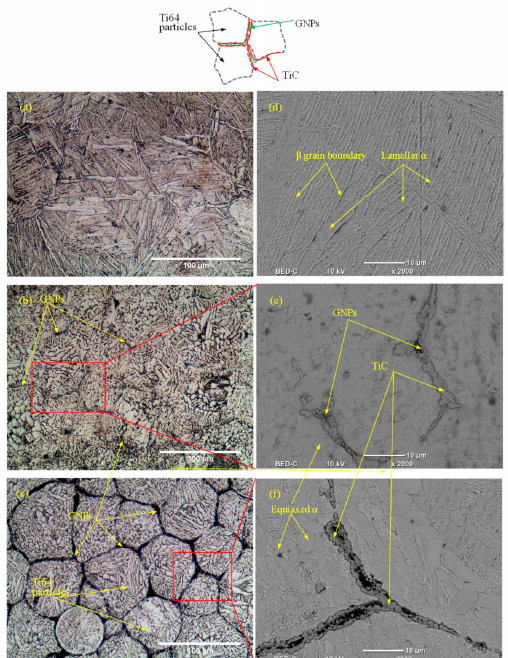
Figure 4. Microstructure images of the fabricated samples ( a , d ) Pure-Ti64; ( b , e ) 0.6 wt.% GNPs, ( c , f ) 1.2 wt.% GNPs.